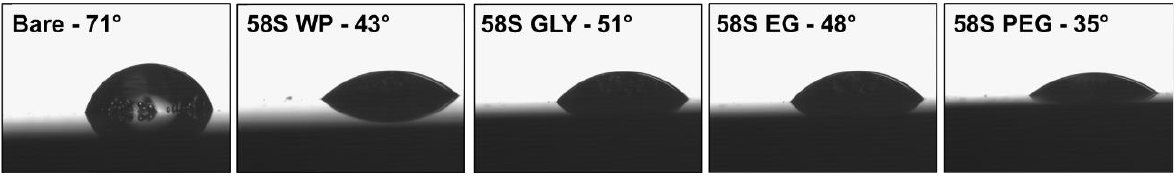
Figure 4. D rops of Hank´s solution on AZ31B alloy with and without 58S coatings during the contact 316 Figure 4. Drops of Hank ´ s solution on AZ31B alloy with and without 58S coatings during the contact angle measurements. angle